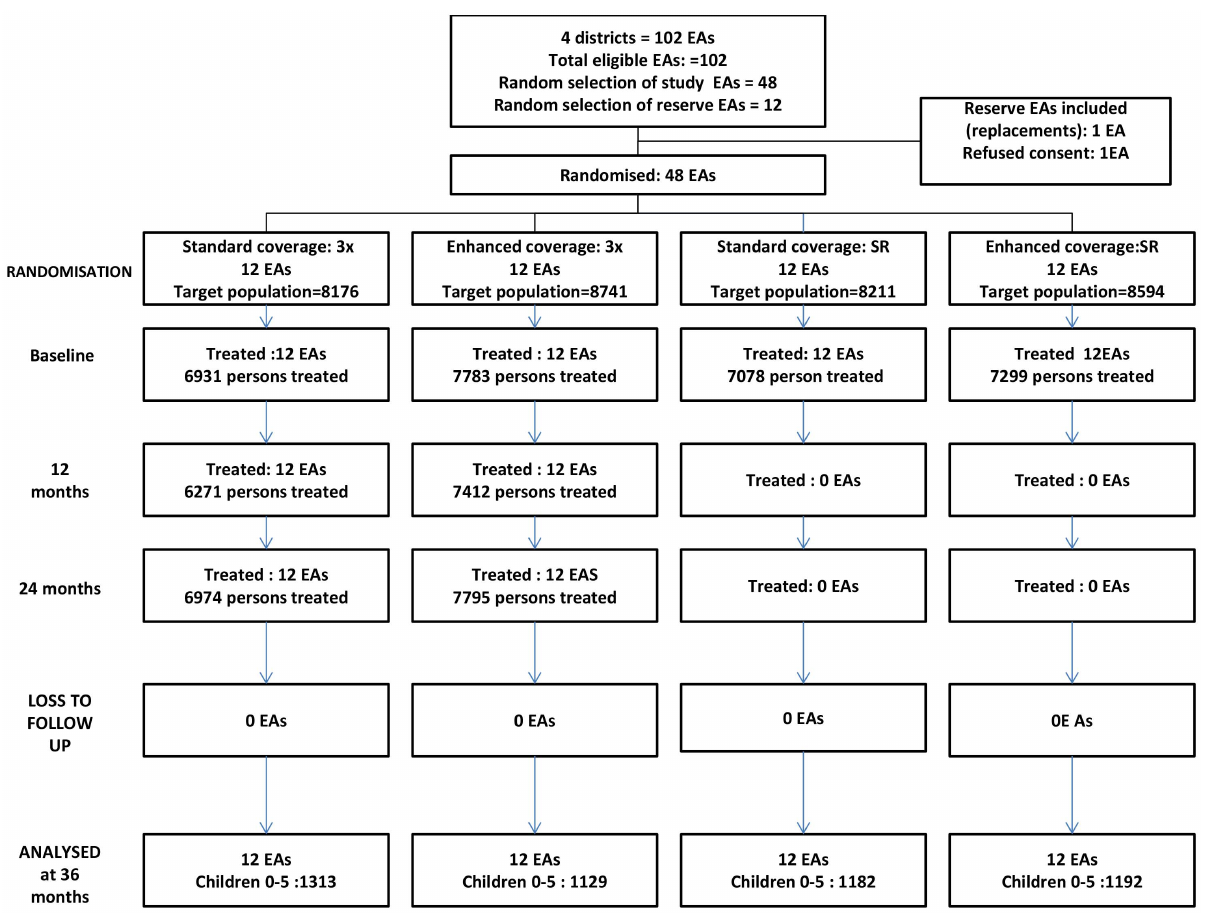
Figure 1. Flow of EAs and participants through the study.